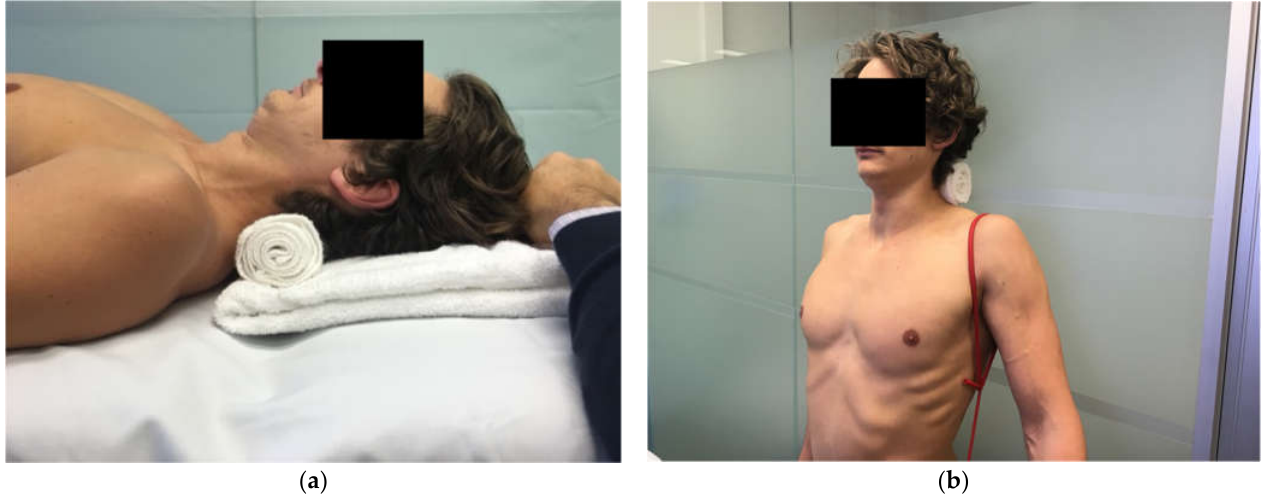
Figure 12. ( a ) Supine deep cervical flexor exercise ( b ) standing deep cervical flexor exercise.